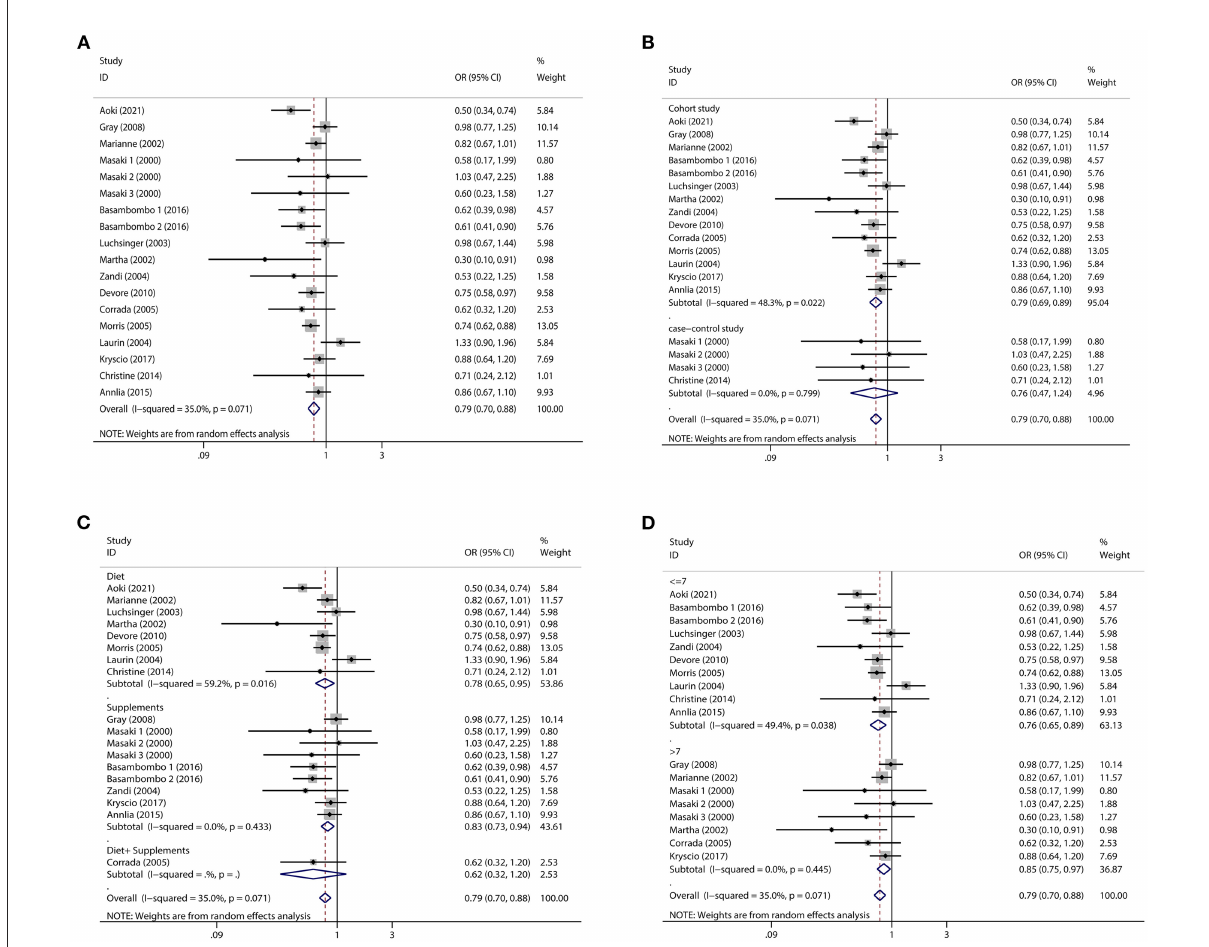
FIGURE2 Forest plots and subgroup analysis plots of high intake of dietary or supplemental vitamin E and risk of dementia. (A) Forest plot. (B) Subgroup analysis by study type. (C) Subgroup analysis by diet and supplements. (D) Subgroup analysis by NOS quality